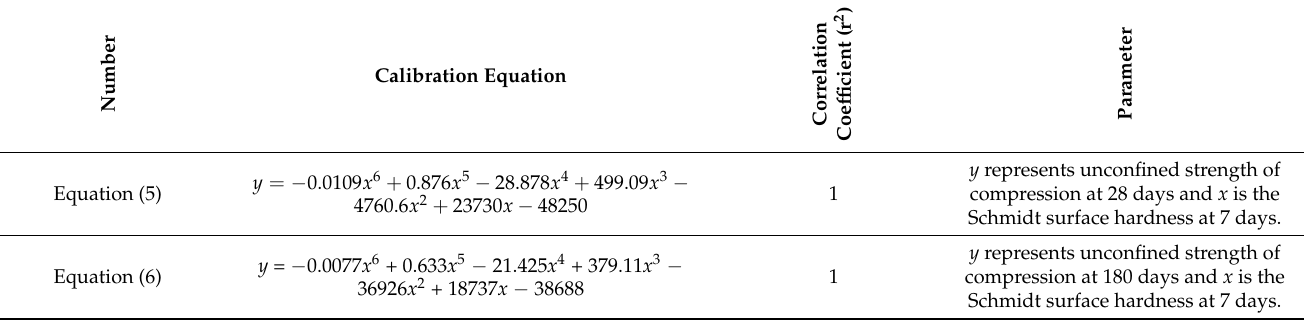
Table 5. Calibration equations for predicting unconfined strength of compression from longitudinal